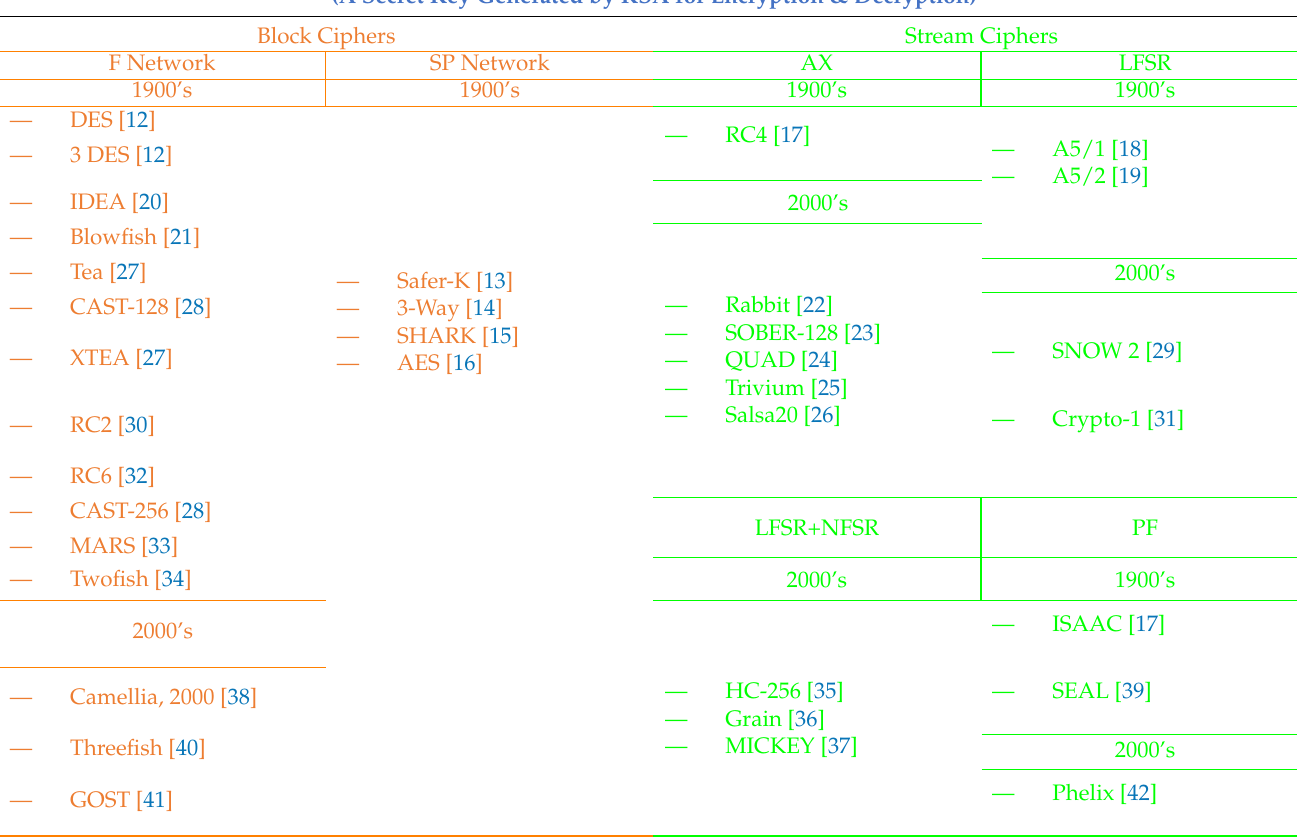
Table 1. List of symmetric key cryptography systems. Symmetric-Key